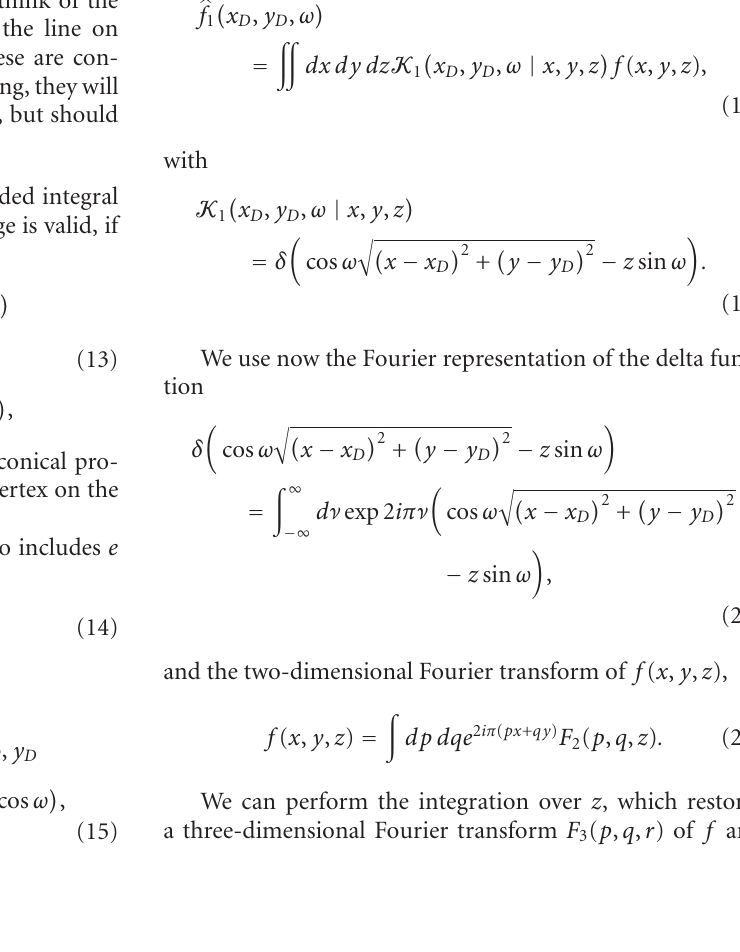
along the line is simply dz M , (11)